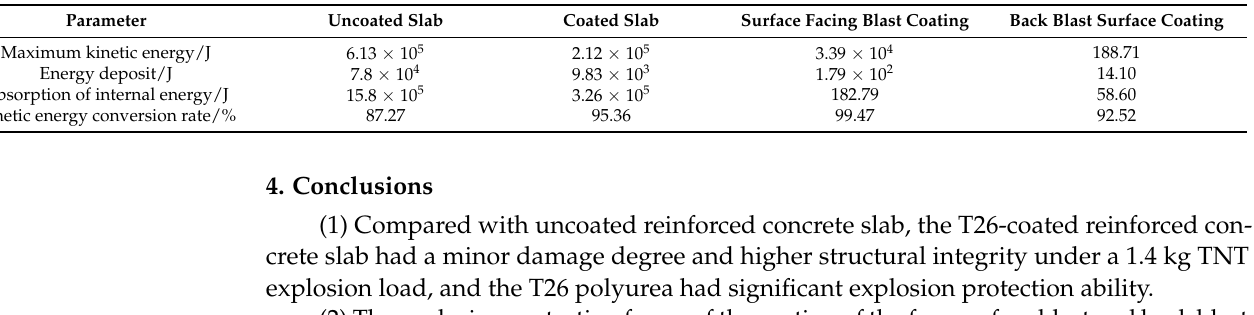
Table 11. Energy changes of reinforced concrete slab and